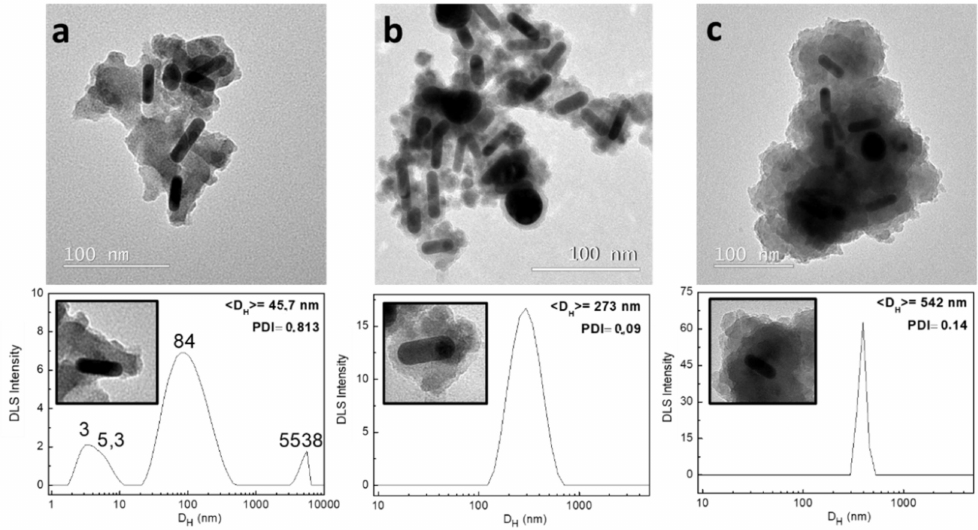
Figure 6. Hybridization dependence with NH 3 amount: ( a ) 0 µ L, ( b ) 15 µ L, and ( c ) 30 µ